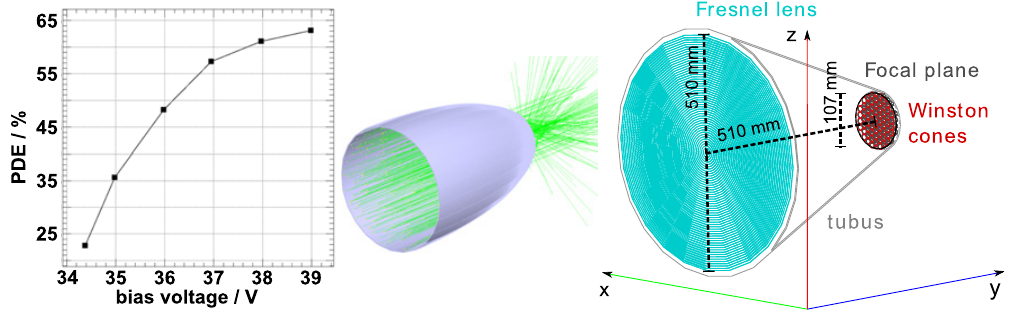
Figure 3. Left : photon detection efficiency (PDE) of a Dolgoshein-type SiPM (cf. [3]) vs. bias voltage measured at our laboratory. Center : simulation of a hollow Winston cone made from polished aluminium. Light entering the cone from the left is concentrated to a smaller area at its exit where an SiPM will be mounted. The light is partly reflected inside the cone so that larger exit angles occur. Right : Geant4 visualization of FAMOUS. Light enters the telescope from the left. A Fresnel lens focuses it onto the focal plane where 64pixels are hexagonally arranged. Each pixel consists of a Winston cone, UV pass filter and four 3 × 3mm 2 SiPMs whose signals will be summed